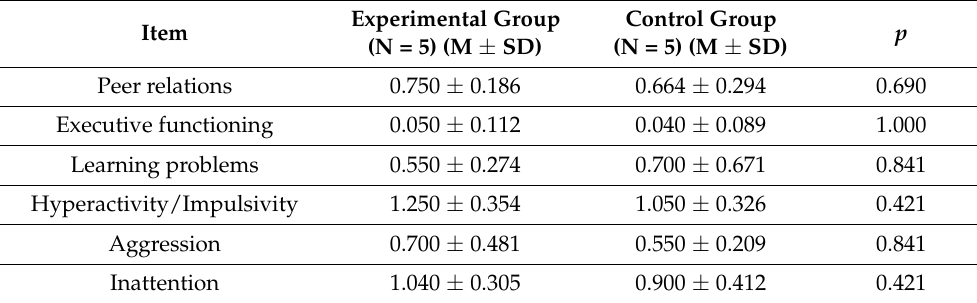
Table 1. Conners Child Behavior Scale score comparison between the experimental group and the control group before the